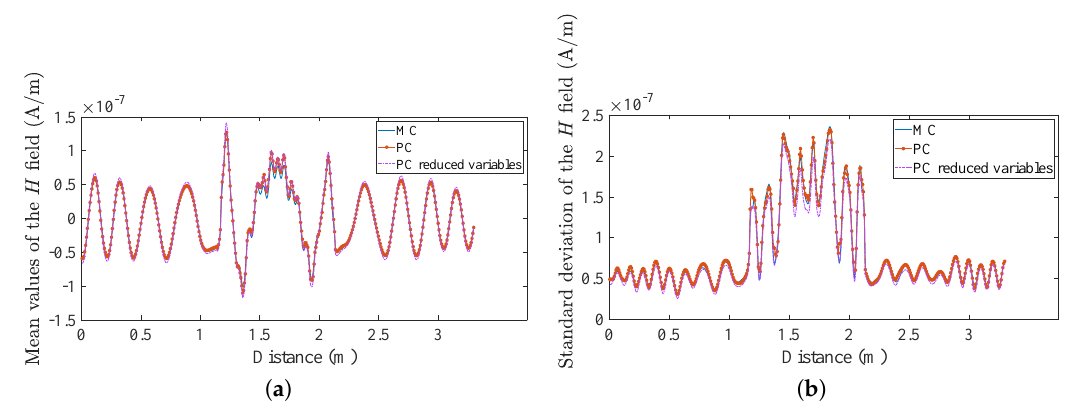
Figure 7. ( a ) Mean value and ( b ) standard deviation of the magnetic field for the second case of the second problem.